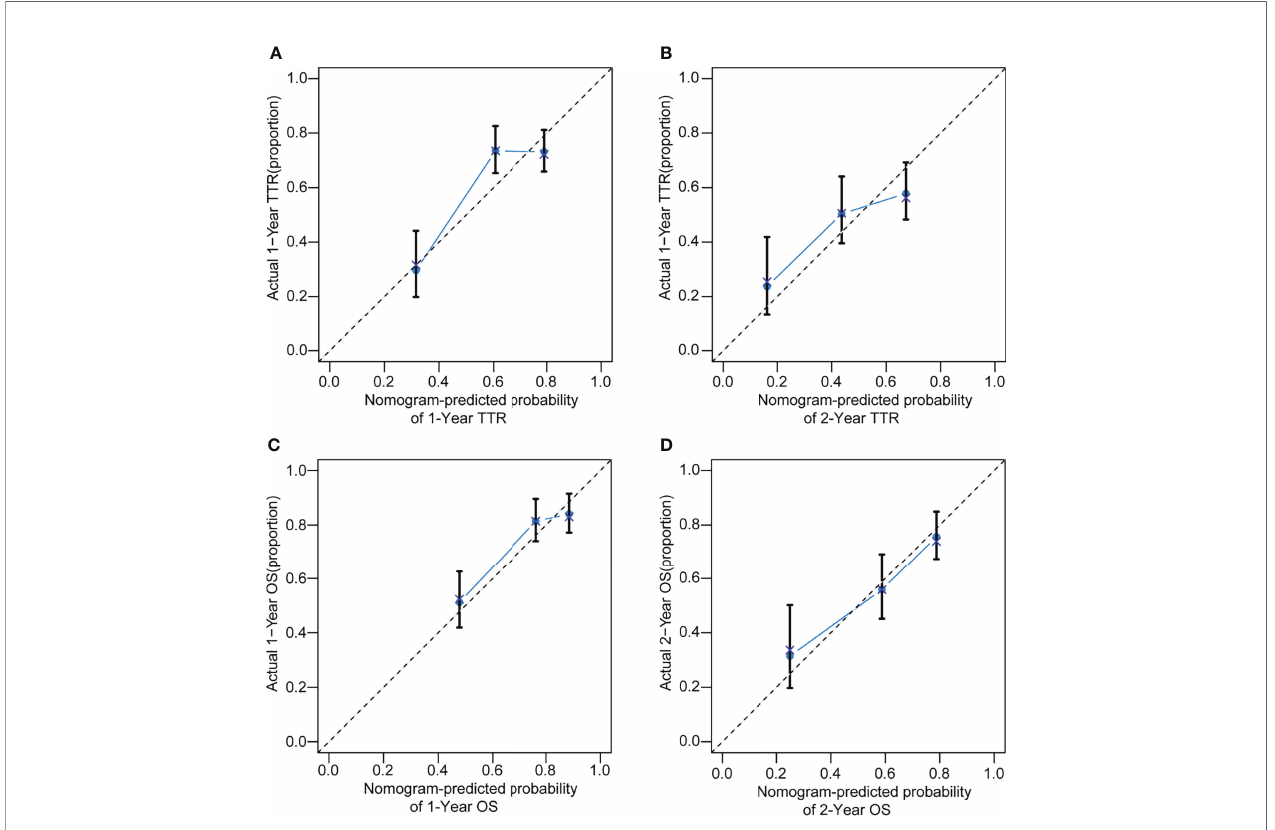
FIGURE 4 | The calibration curve for predicting TTR at 1 years (A) , 2 years (B) and OS at 1 years (C) , 2 years (D) in HCC patients with MVI after radical